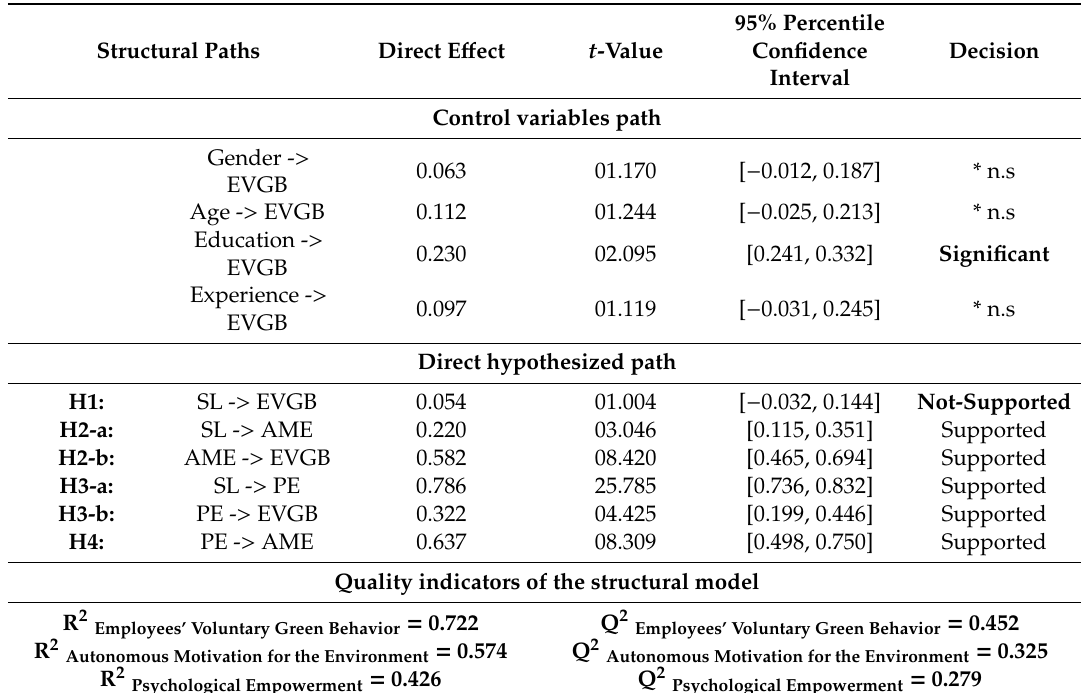
Table 4. Results of the structural